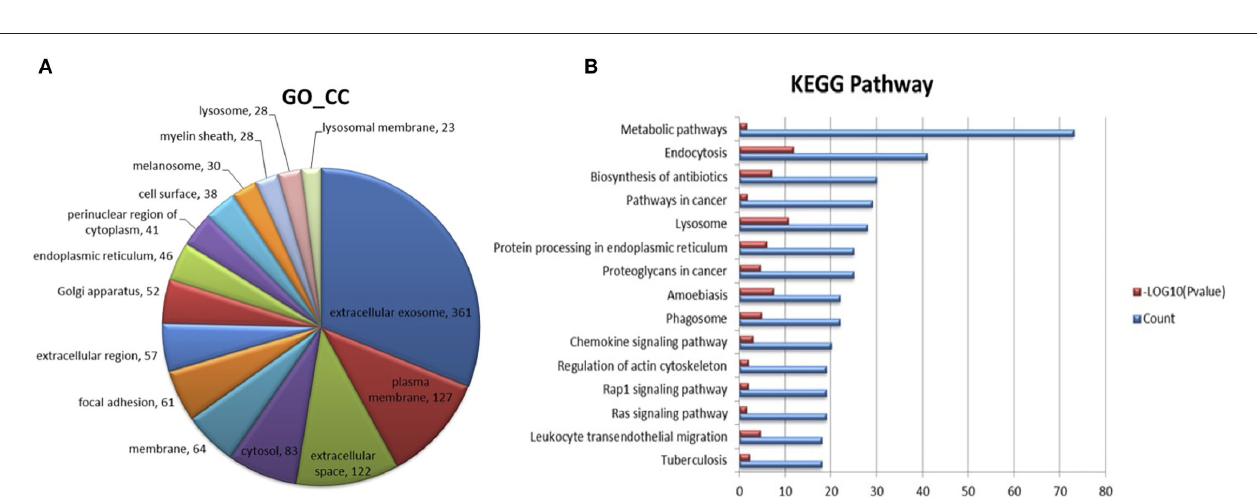
FIGURE 5 | Proteome analysis of milk-exosome-enriched proteins by mass spectrometer detection and function prediction of the specifically enriched proteomes. (A) Abundant proteome analysis by mass spectrometer of milk-exosomes. The 15 most abundant proteomes in milk-exosomes are color labeled in the pie charts. (B) Functions for the proteomes significantly enriched in milk-exosomes were identified by KEGG analysis. Top 15 abundant enriched pathways are listed, endocytosis pathways involving the proteomes are shown in the